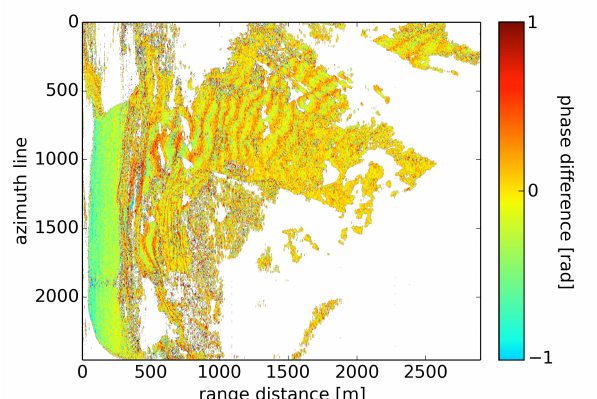
Figure 10. Differences between two single pass interferograms separated by a temporal baseline of 24 h associated with a lake surface drop of 0.4m. Each of the two interferograms was computed as an average over 10 consecutive interferograms in a timespan of 40